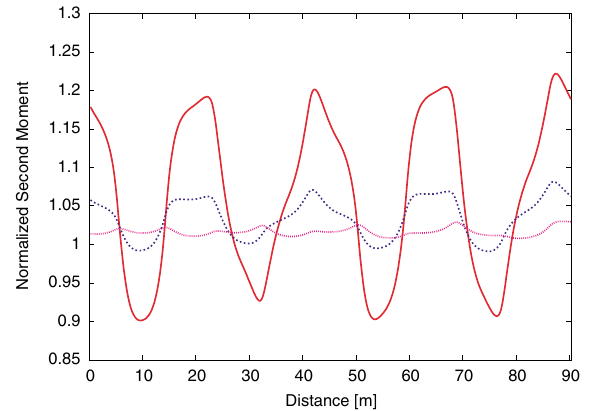
FIG. 6. (Color) Vertical second moment of the beam, normal- p , taken over one turn near the end of accumu- (cid:10) ized to (cid:1)(cid:1)(cid:1)(cid:1)(cid:1)(cid:1)(cid:1)(cid:1)(cid:1)(cid:1)(cid:1) (cid:8) y y lation of 4 : 37 (cid:2) 10 13 protons. The curves correspond to longitudinal slices of beam at approximately 0 : 01 (cid:12) (blue dashed line), and (cid:12) line), 0 : 25 (cid:12) l